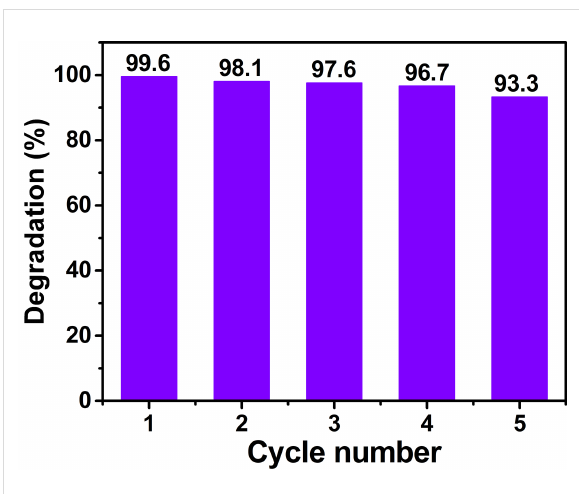
Figure 8: Five successive photocatalytic MB degradation (%) cycles over the CuO/tourmaline-4:1 composite. Experimental conditions: [MB] 0 = 0.01 g L − 1 , [photocatalyst] 0 = 0.5 g L − 1 , volume = 100 mL, temperature = 25 °C.